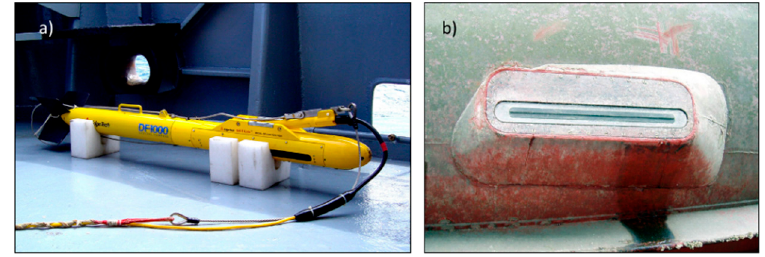
Figure 5. Side-scan sonar systems. ( a ) towed behind the survey vessel and ( b ) hull-mounted